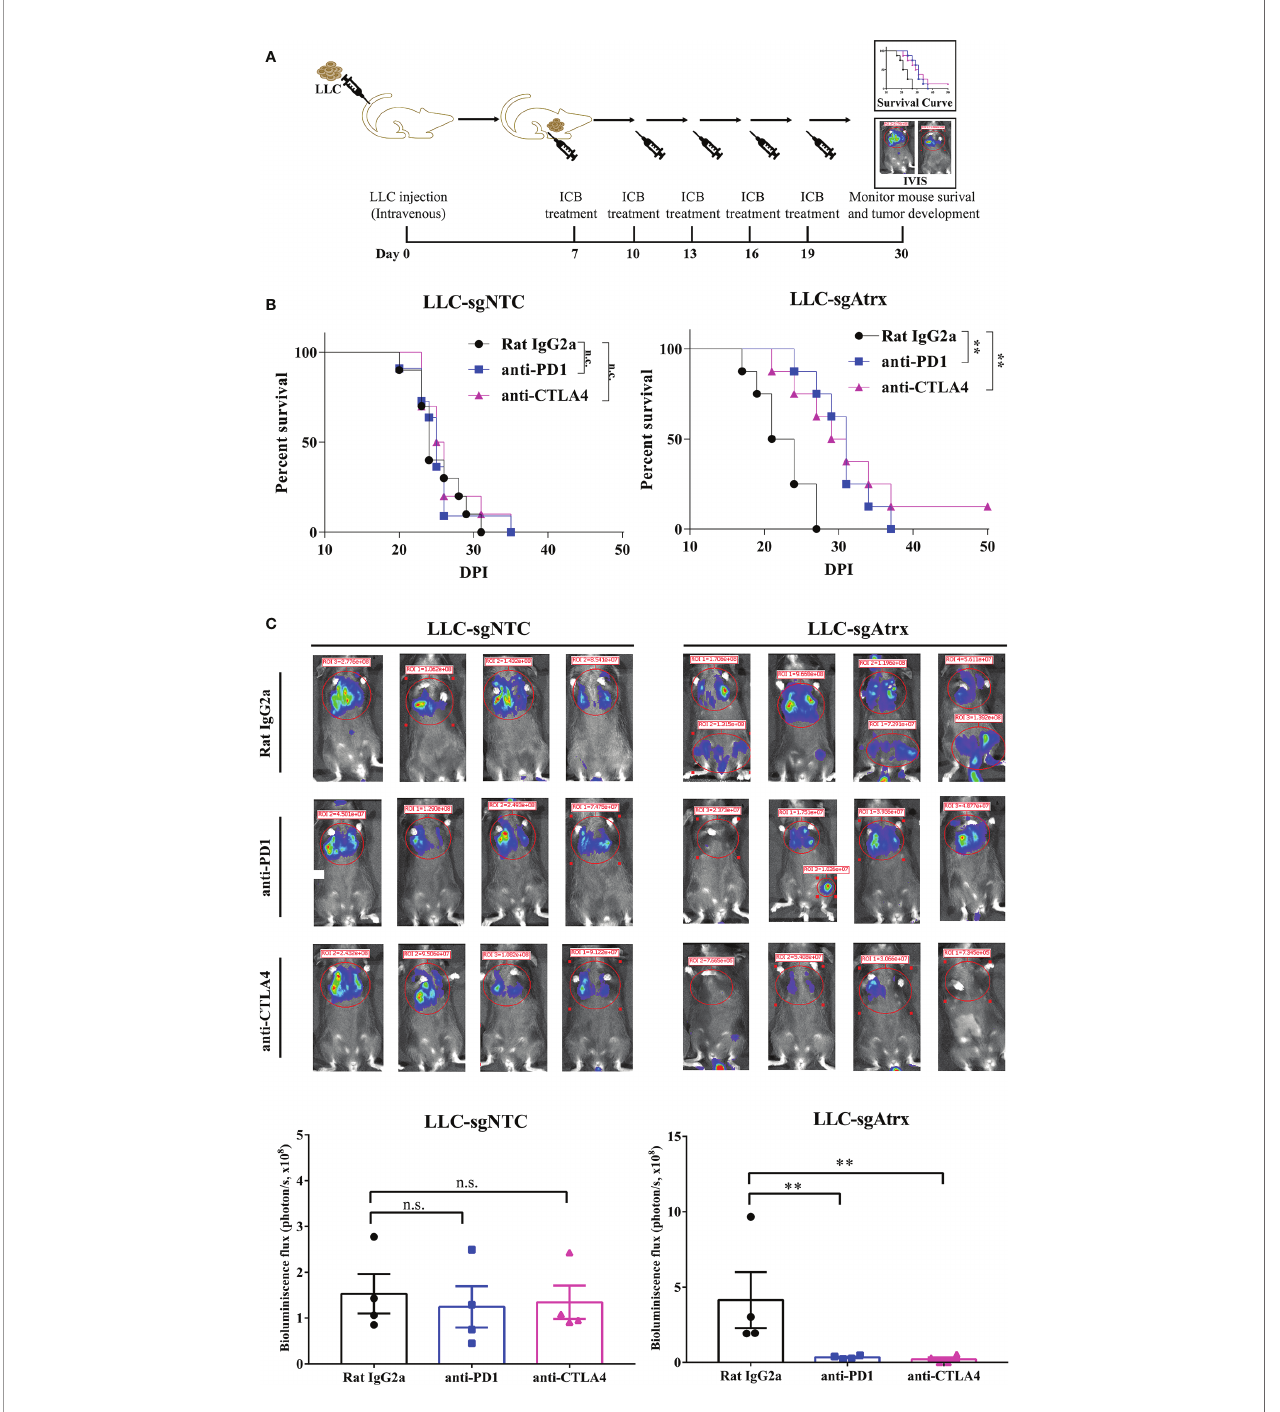
FIGURE 4 | Atrx de fi ciency sensitizes NSCLC to ICI treatment in orthotopic mouse model. (A) experimental design for establishment of the orthotopic mouse model by intravenous seeding of tumor cells to analyze the tumor burden in vivo . (B) Kaplan-Meier survival curves of mice bearing LLC tumors with and without Atrx de fi ciency after anti-PD1 or anti-CTLA4 treatment. Neither aCTLA4 (n = 4) nor aPD1 (n = 4) treated mice showed a signi fi cant survival difference in Atrx-expression mice, compared with control group (n = 4) ( P = 0.9341, 0.9412). Both aCTLA4 (n = 4) and aPD1 (n = 4) treated mice showed a signi fi cant survival difference in Atrx- de fi cient mice, compared with control group (n = 4) ( P = 0.006, 0.003). (C) The luciferase signals detected by IVIS in mice bearing LLC generated tumors with and without Atrx de fi ciency after ICI or isotype antibody treatment. Neither aCTLA4 (n = 4) nor aPD1 (n = 4) treated mice showed a signi fi cant signal difference in Atrx- expression mice, compared with control group (n = 4) ( P = 0.8521, 0.7644). Both aCTLA4 (n = 4) and aPD1 (n = 4) treated mice showed a signi fi cant signal difference in Atrx-de fi cient mice, compared with control group (n = 4) ( P = 0.005, 0.002). ** P < 0.01. n.s., not signi fi